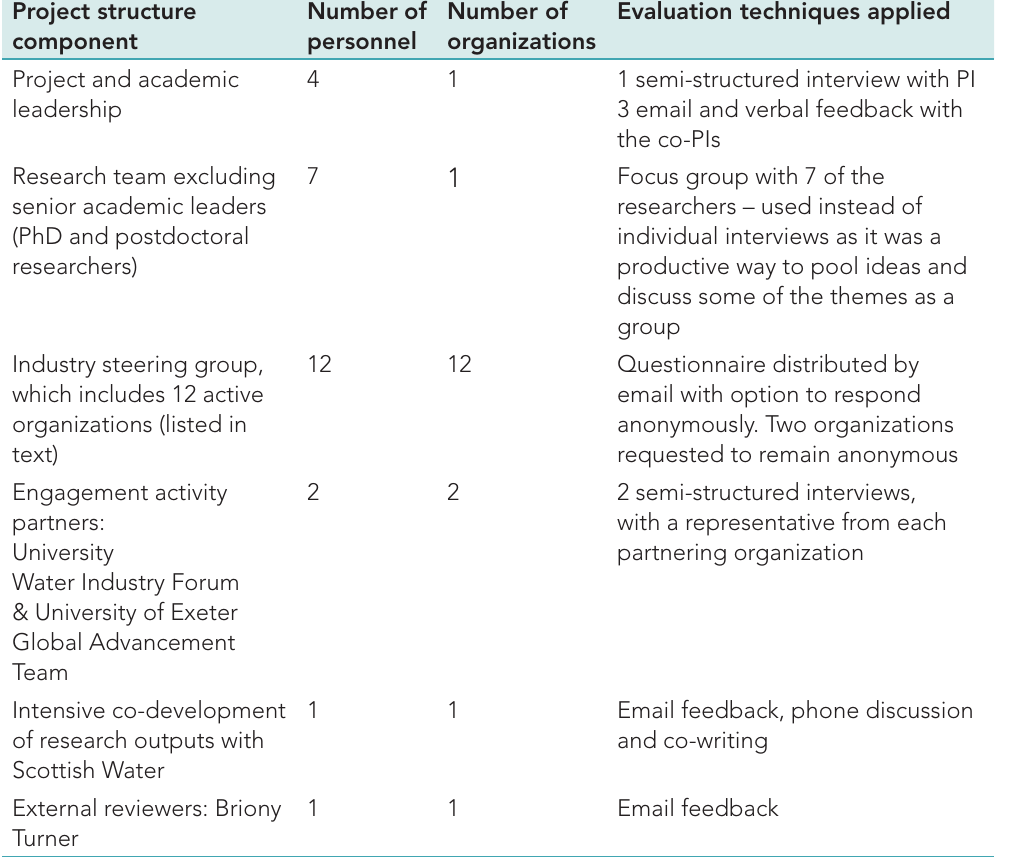
Table 1: overview of the project structure and the evaluation techniques with